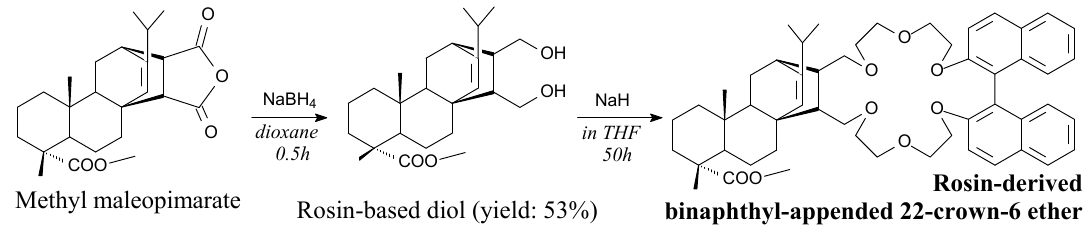
Scheme 37. Synthesis of rosin-derived binapthyl-appended 22-crown-6 ether.